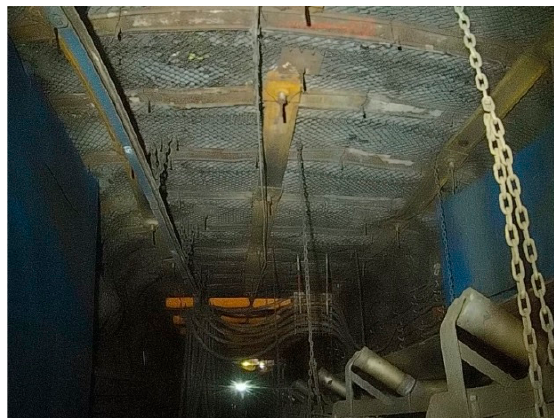
Figure 14. Effect of grouting support.